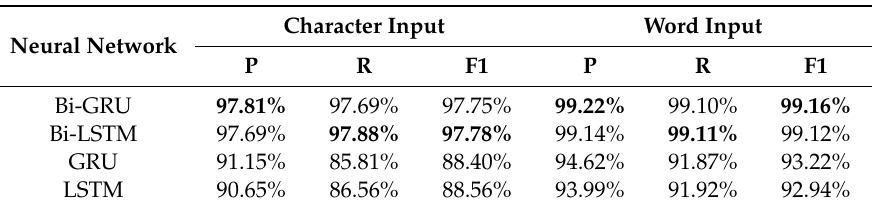
Table 7. The segmentation results of each neural network are compared for di ff erent input models. Precision (P), recall (R), and F1-score